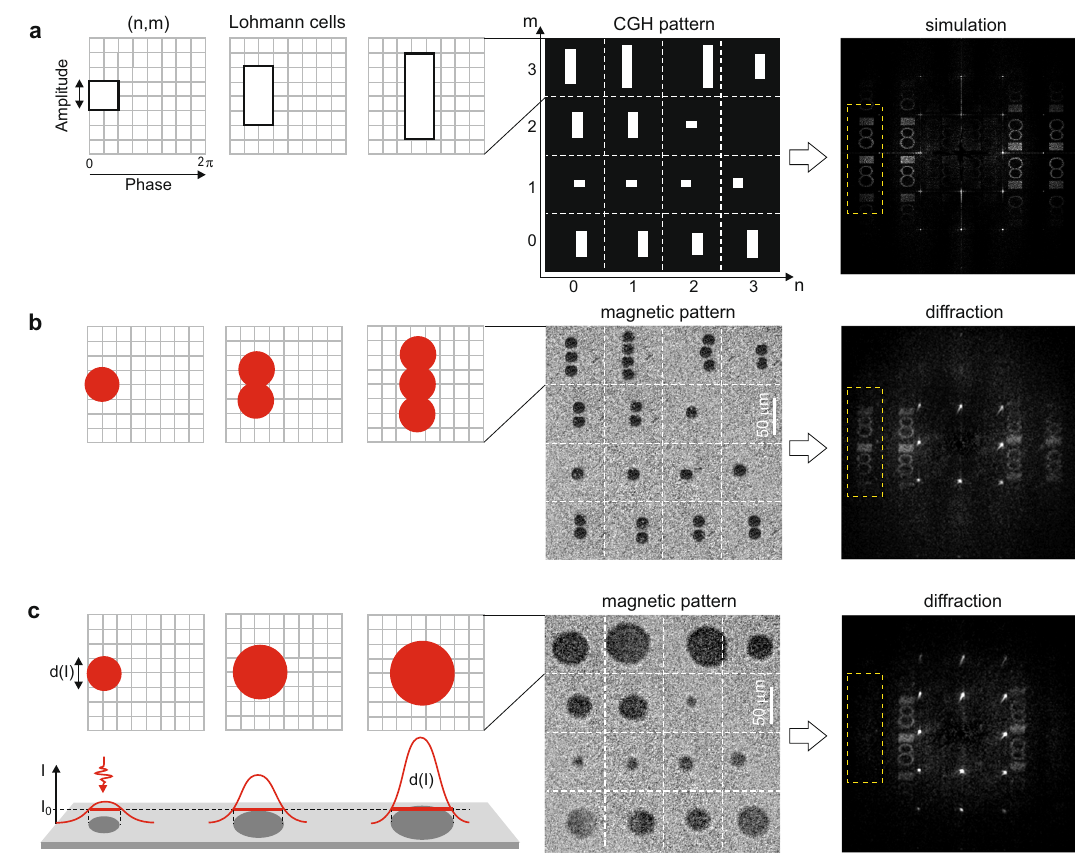
Fig. 3 | Complex opto-magnetic holograms with detour-phase encoding. a Simulation of classical detour-phase encoding using the Lohmann method. The heights and offsets of rectangular apertures are linear functions of the amplitude and phase values from a given CGH cell, respectively. Suppression of the con- jugated images is notable. b From left to right: the approximation of the rectan- gular Lohmann openings with multiple point-by-point exposures switching magnetic spots of fi xed diameters; fragment of written magnetic pattern; experi- mentally acquired diffraction image showing asymmetrical visibility of higher-